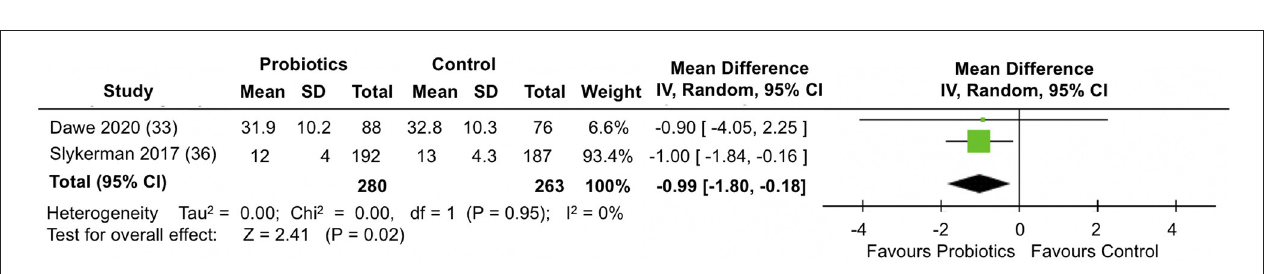
FIGURE 5 | Meta-analysis of the effect of probiotic supplementation on the proportion of participants scoring above cut-off in EPDS depression scores in the perinatal period.